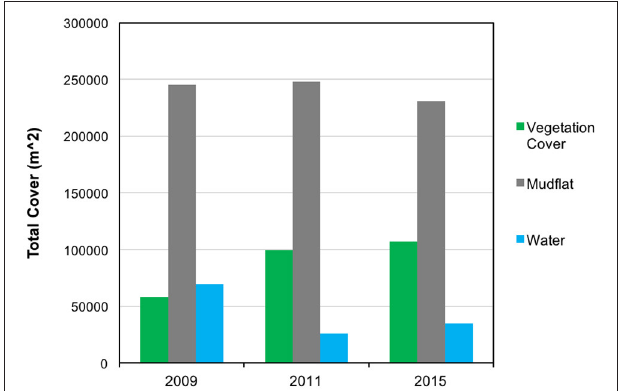
FIGURE 3 | Cover type change. Mudflat was the dominant cover type across all 3 years. Vegetation increased at a rate of 20,580 m 2 /year between 2009 and 2011, and 1,979 m 2 /year between 2011 and